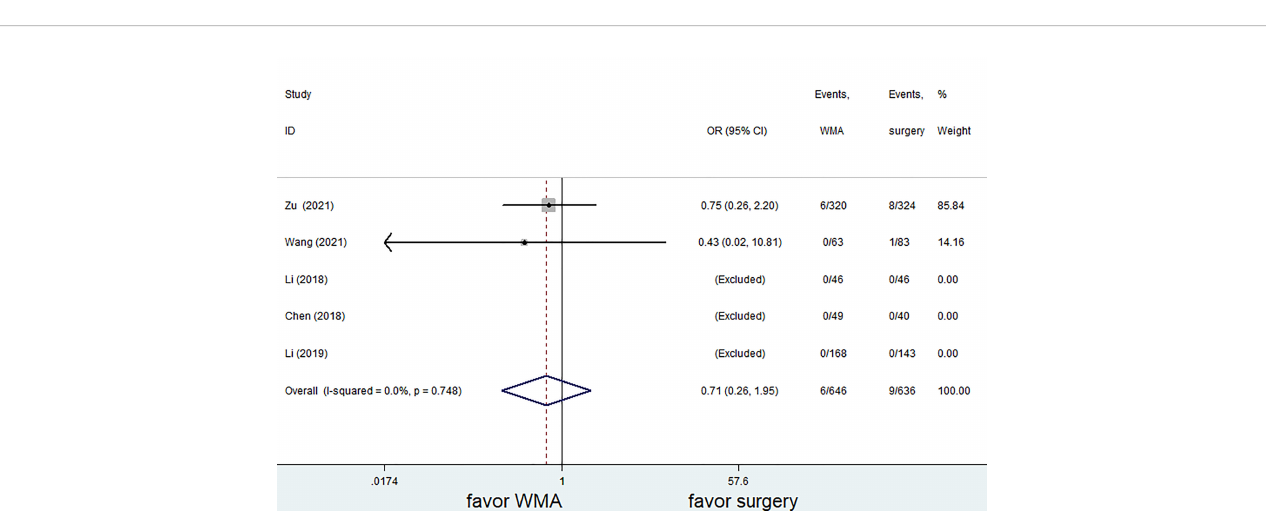
FIGURE 9 Forest plot of lymph node metastasis for comparing MWA with surgery in patient with PTMC. MWA, microwave ablation, PTMC, papillary thyroid